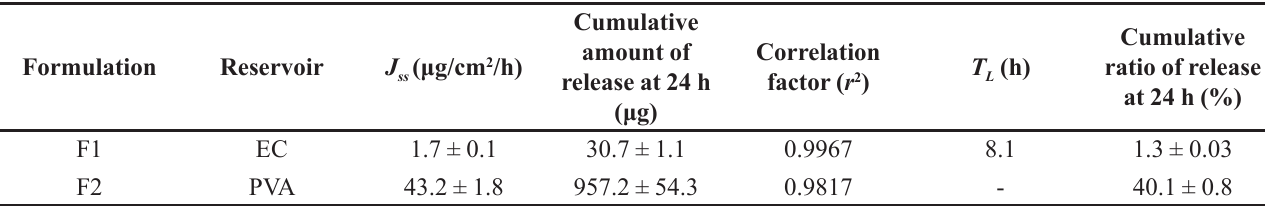
TABLE I - The permeation of ISDN releasing from the drug reservoir across M1